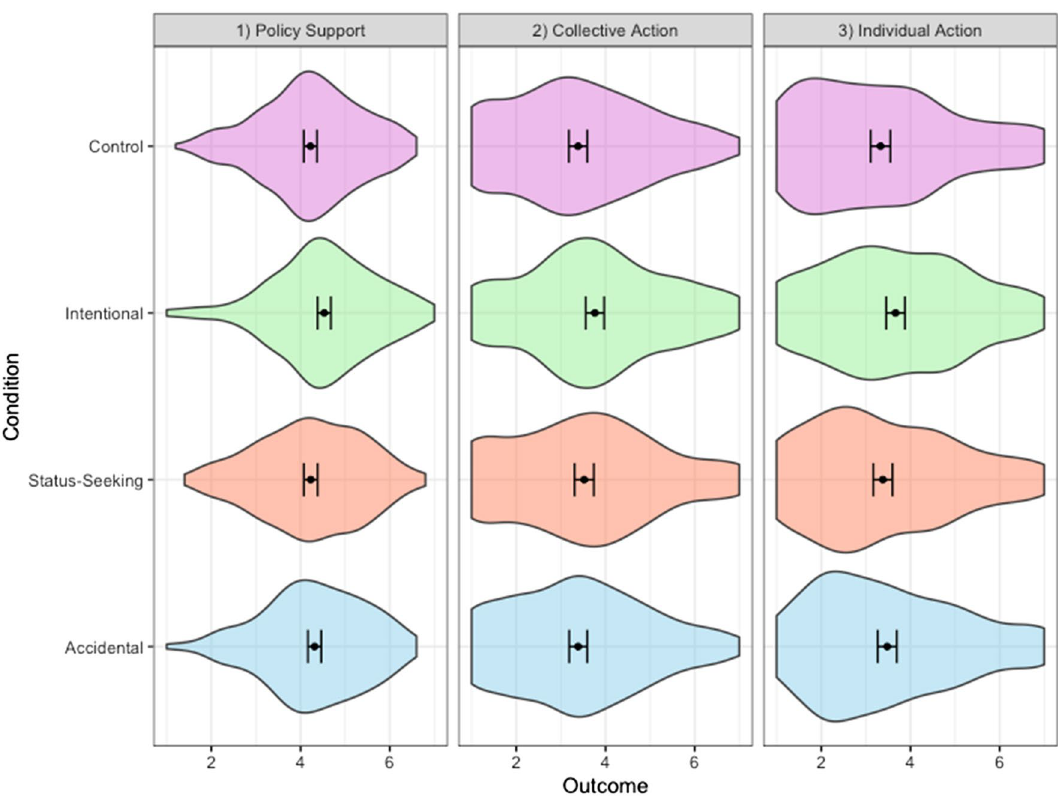
Figure 2. Climate policy support and action intentions across stories. Error bars represent 95% confidence interval of the means. Policy support, collective action and individual action intentions measured using 10-item, 3-item and 3-item composites respectively. All items measured on Likert scales of 1(not at all) to